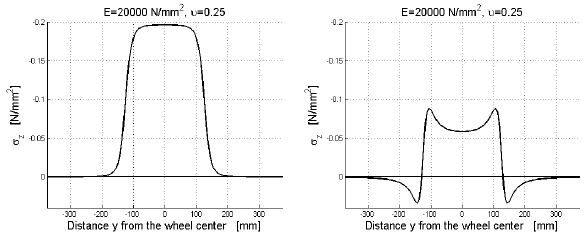
Figure 14: Superficial profiles of σ z on the A-A vertical cross-section of Figure 11: Boussinesq’s solution on the left and the second order solution on the